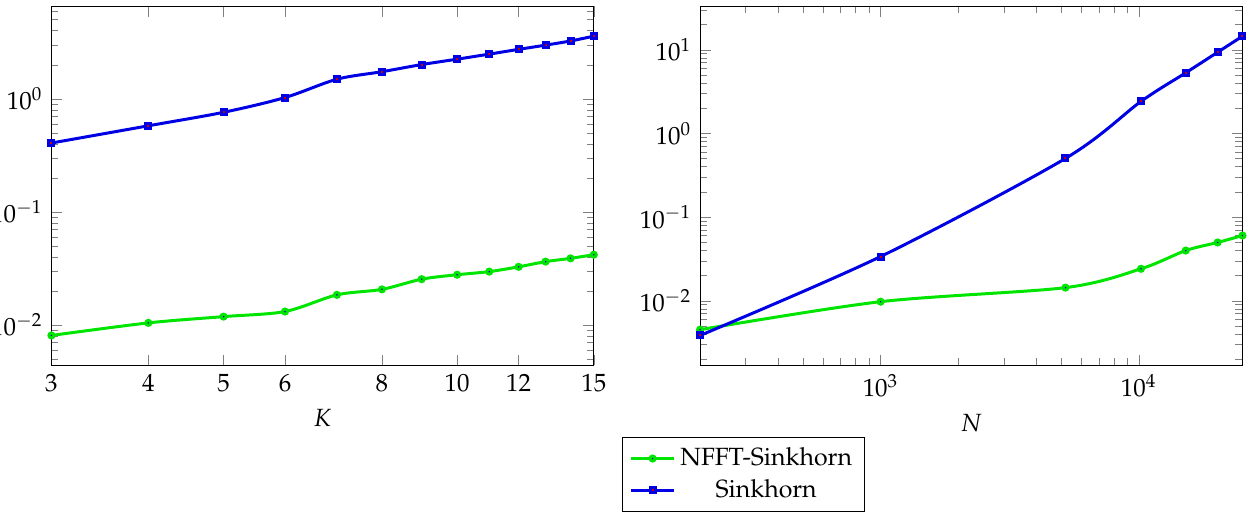
Figure 2. Computation time in seconds of MOT η with tree-structured cost function with regulariza- tion parameter η = 0.1. Left : fixed N = 10 4 . Right : fixed K =